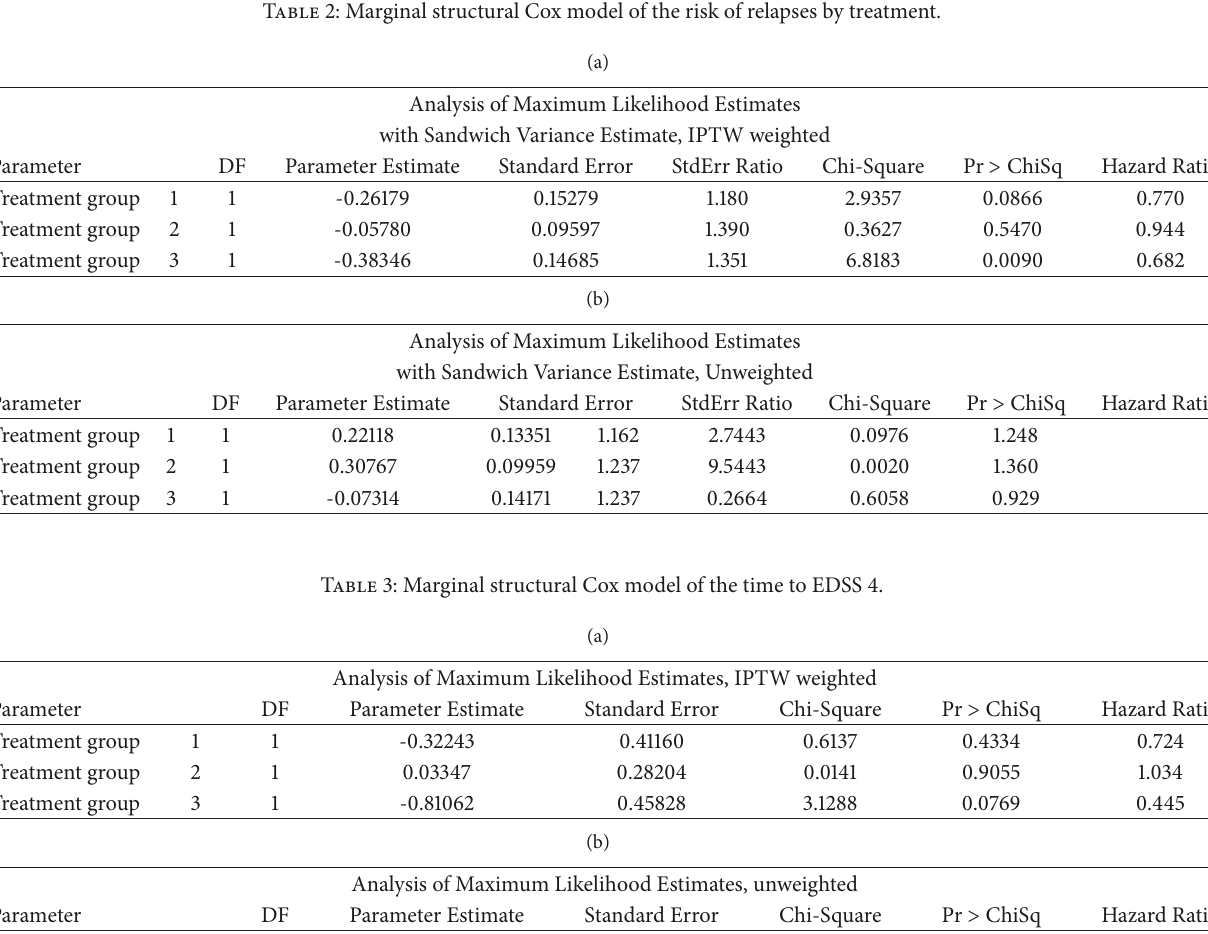
Table 2: Marginal structural Cox model of the risk of relapses by treatment.